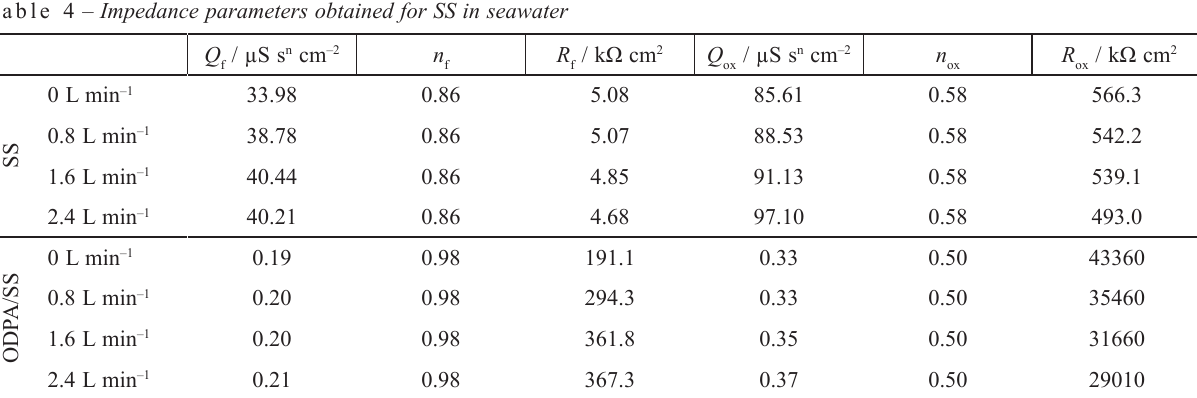
Table 4 – Impedance parameters obtained for SS in seawater